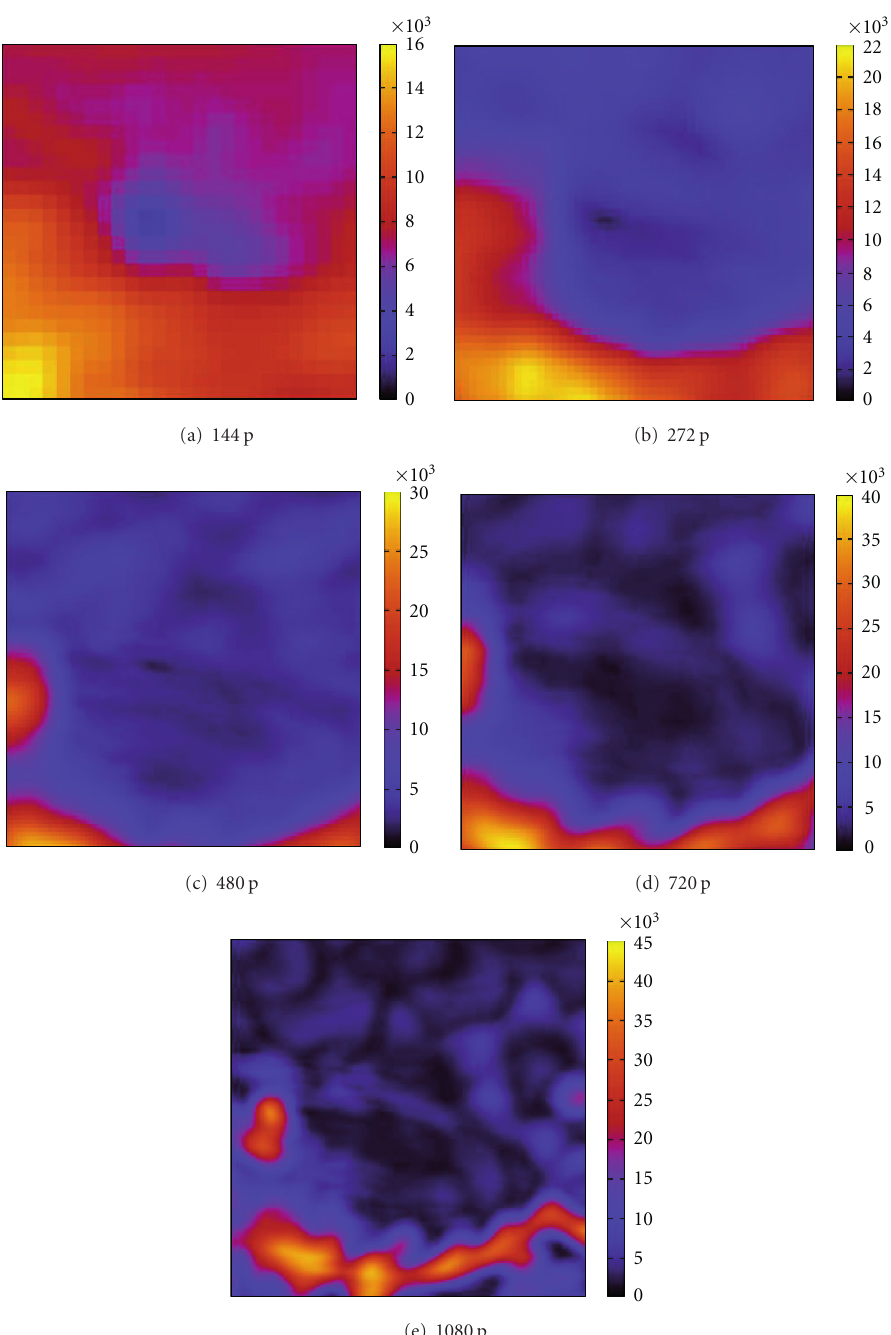
Figure 2: SAD maps for a sun flower